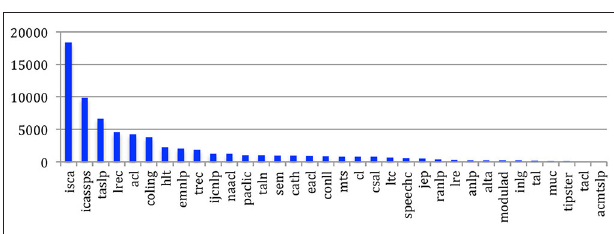
FIGURE 3 | Number of documents for each